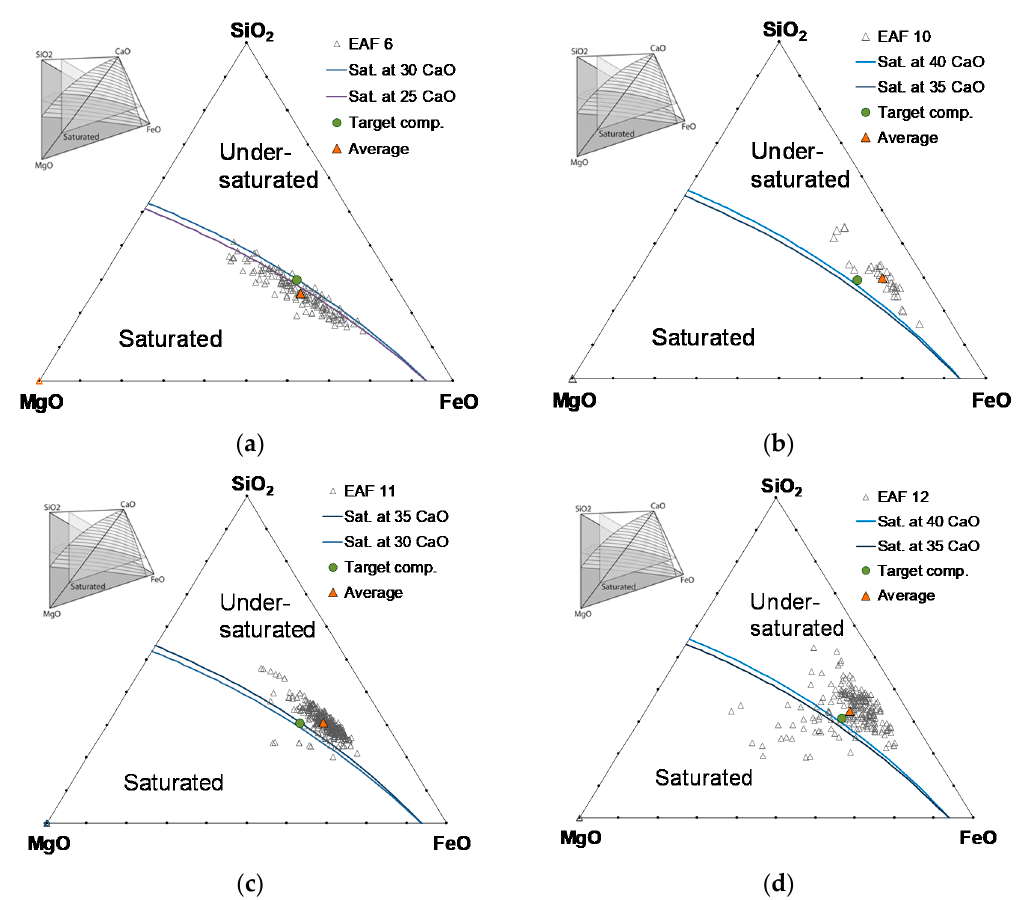
Figure 2. Distribution of slag analysis data from EAF heats for carbon steelmaking based on DRI (4 different EAFs ( a – d )), in the system CaO-SiO 2 -FeO-MgO-5% Al 2 O 3 ; lines indicate MgO saturation at 25% to 40% CaO and 1600 ◦